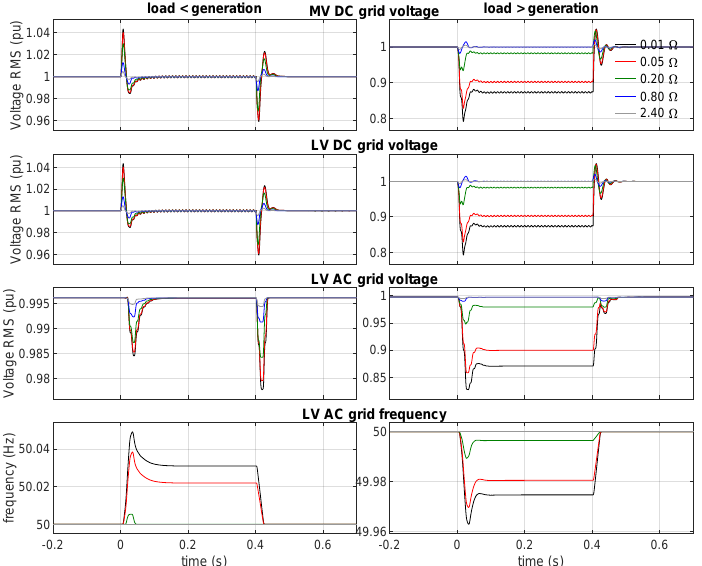
Figure 26. Voltage and frequency levels in the hybrid AC/DC network following unbalanced phase-ground faults in the HV AC grid for the considered fault